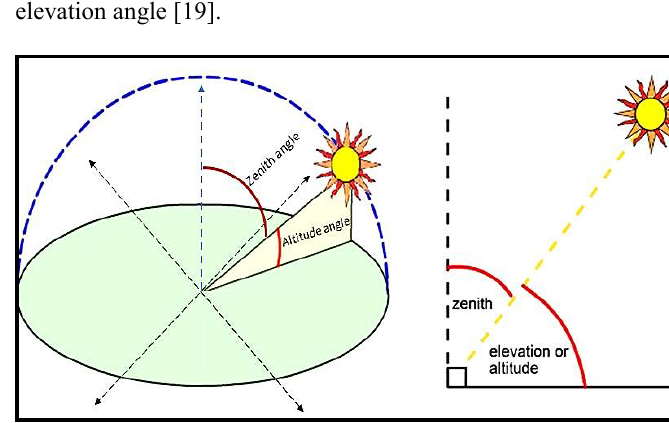
Figure 2. Air mass definition [16].